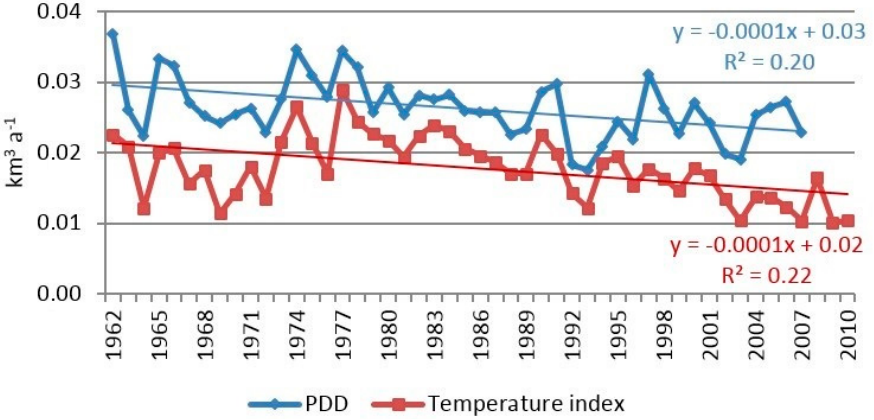
Figure 11. Glacier runoff by the PDD and the temperature-index methods Qiedeke.